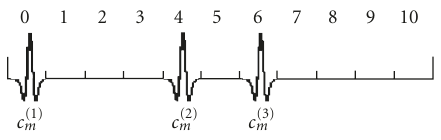
Figure 1: Positioning of pulses by a time-hopping